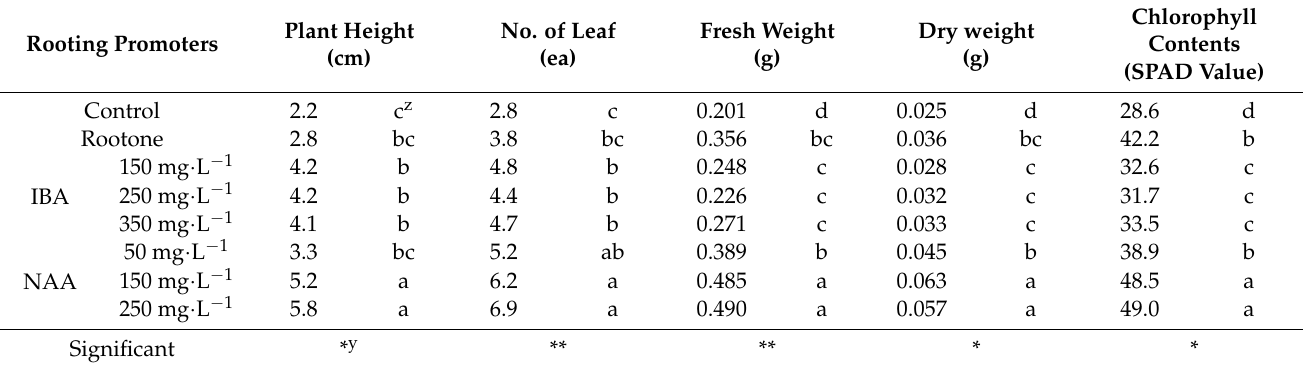
Table 3. Characteristics of shoot growth as affected by rooting promoters at 70 days after cutting Rhododendron micranthum Turcz..